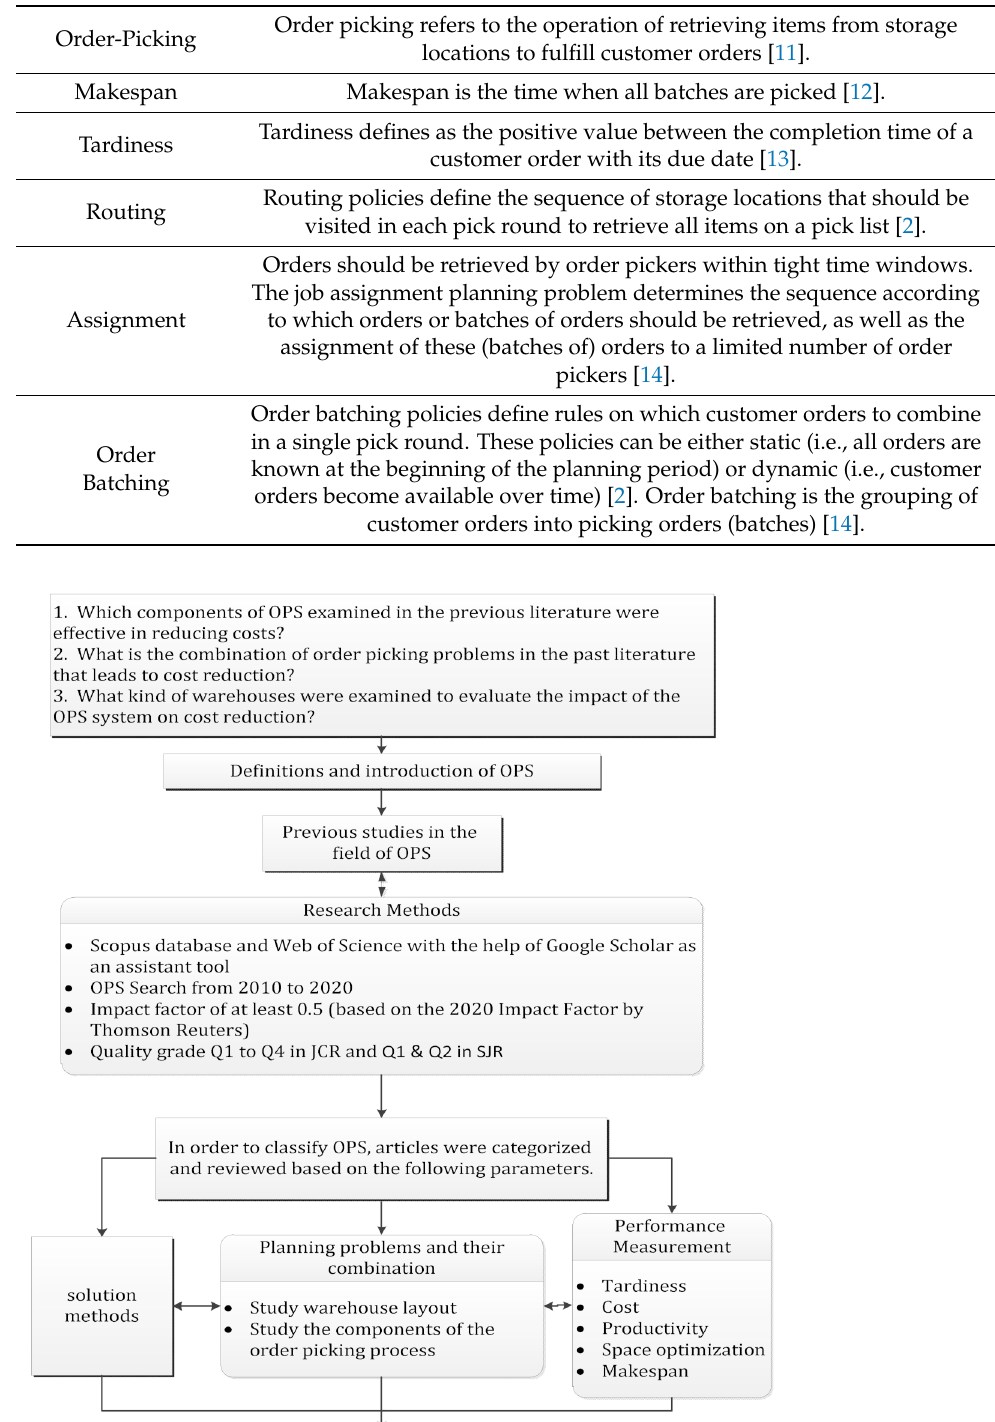
Table 1. The concepts and definitions.